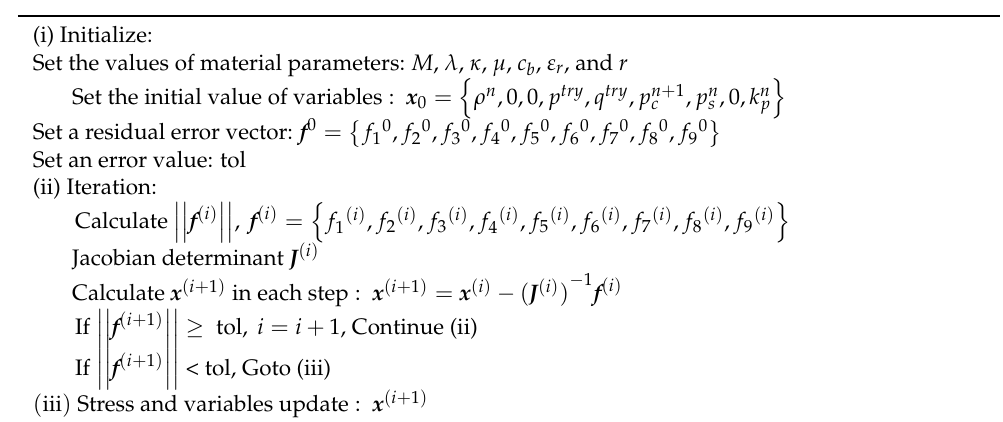
Table 1. Procedure of the